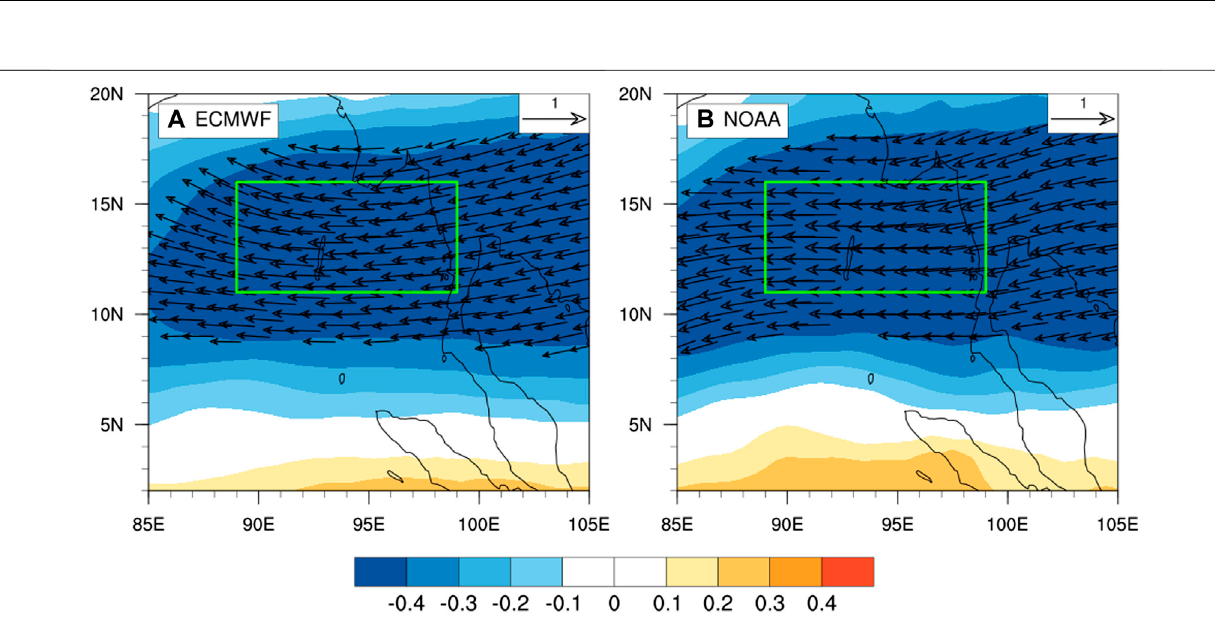
TABLE 1 | Mutual correlation coef fi cients among the SLP TCP,4 , SST SWA,34 , U850 EJ,3 , and U500 BOB,4 in the ECMWF and NOAA data.